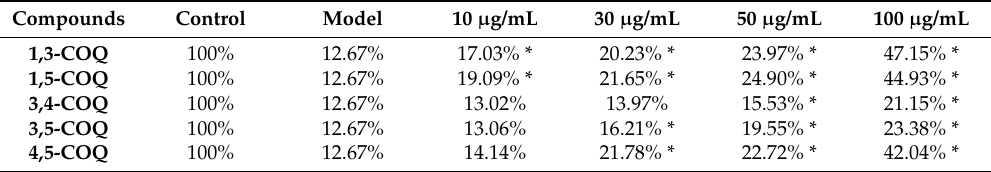
Table 2. The viability percentages of five di-COQs towards • OH-damaged bmMSCs in the MTT assay. Compounds Control Model 10 µ g/mL 30 µ g/mL 50 µ g/mL